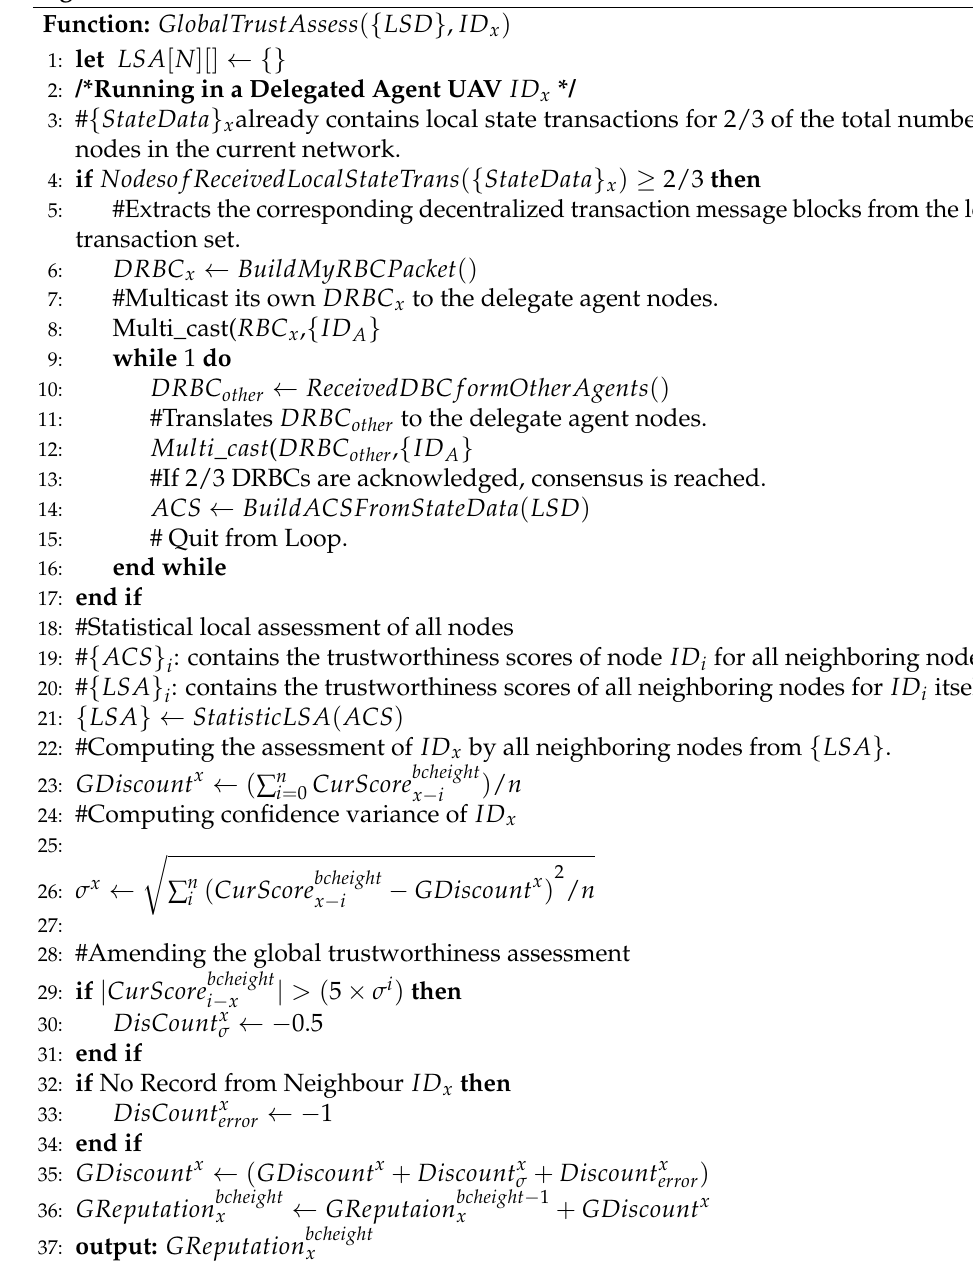
Algorithm 3 Function: Global Trust